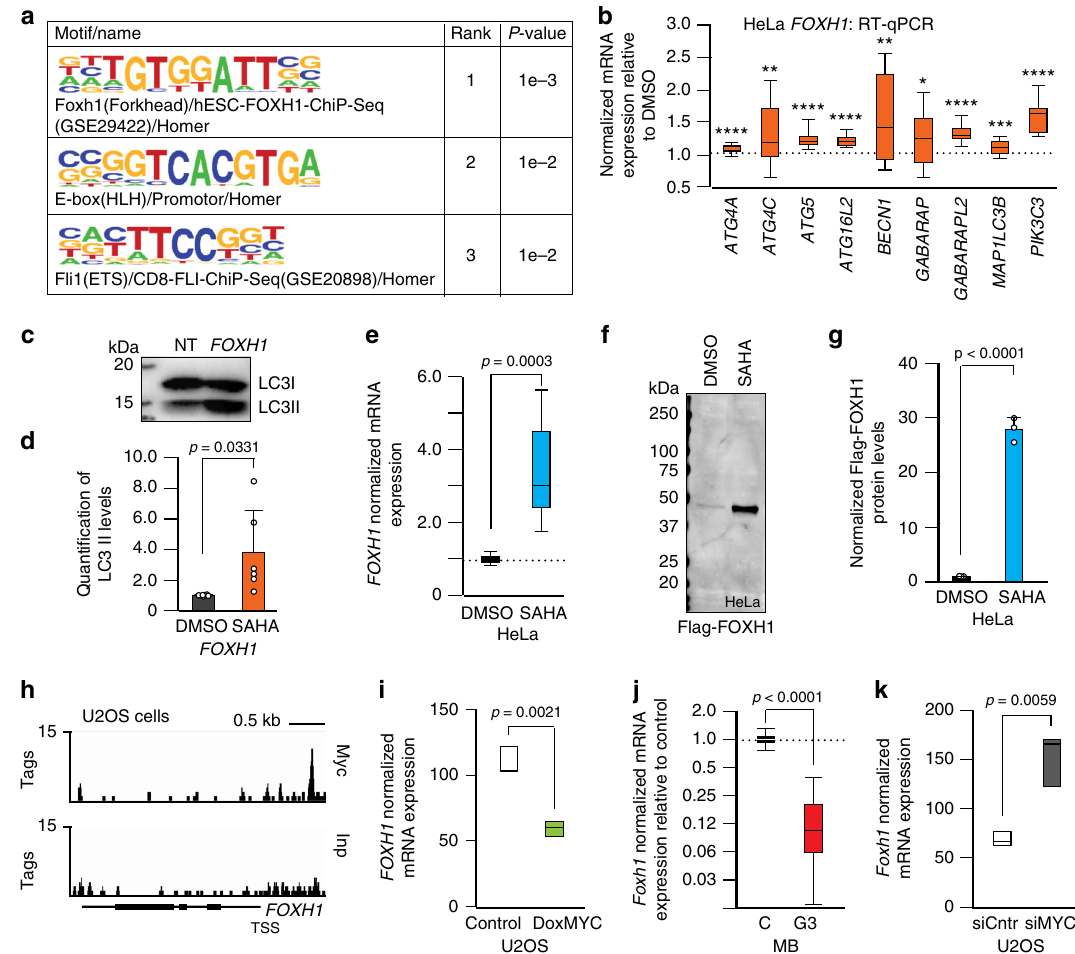
Fig. 7 FOXH1 is an additional activator of autophagy and responds to the HDACs/MYC axis. a Motif analysis using HDAC2-binding sites for autophagy genes identi fi ed the FOXH1 motif. b RT-qPCR of autophagy genes in FOXH1-overexpressing HeLa cells ( n = 6 biologically independent samples) p < 0.01. c Representative LC3 immunoblot from FOXH1-overexpressing cells. d Quanti fi cation of the LC3II/LC3I ratio normalized to Coomassie stained immunoblots, used as loading control ( n = 6 independent experiments). e FOXH1 RT-qPCR in SAHA-treated HeLa cells (20 μ M for 24 h; n = 7 biologically independent samples). f Representative immunoblot of FOXH1 overexpression in HeLa cells treated with DMSO or SAHA (20 μ M for 24 h). g Quanti fi cation of f ( n = 3 independent experiments) normalized to Coomassie stained immunoblots, used as loading control. h MYC binding to